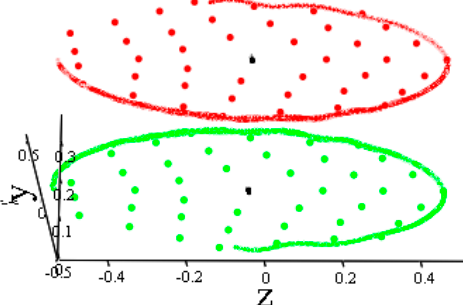
Figure 3. The angular speeds of the two B 42 discs.